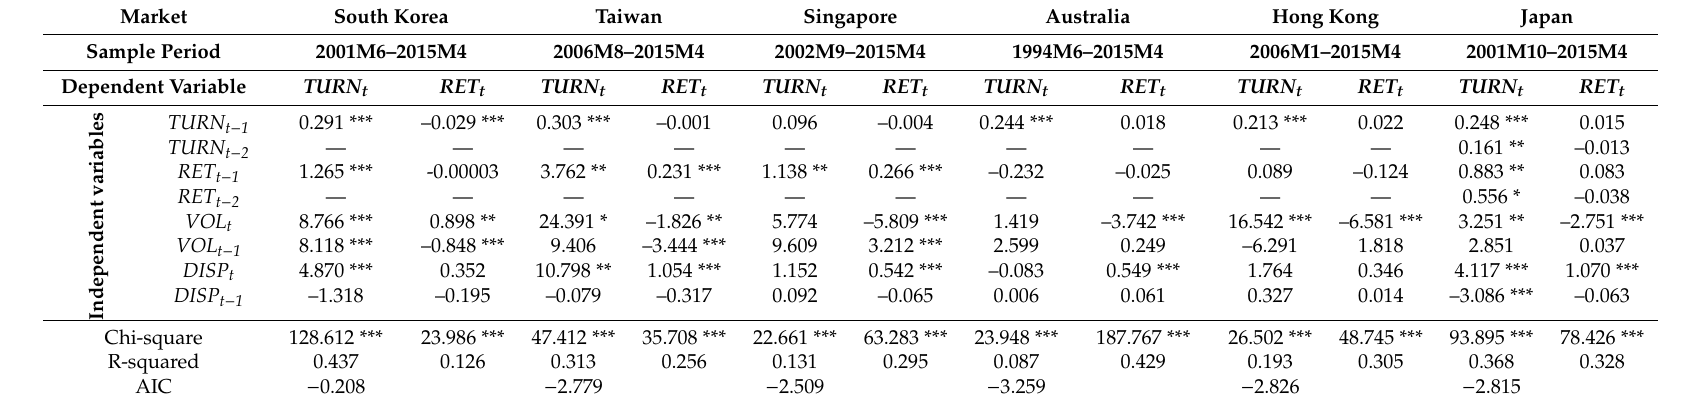
Table 2. Vector autoregression (VAR) model estimation